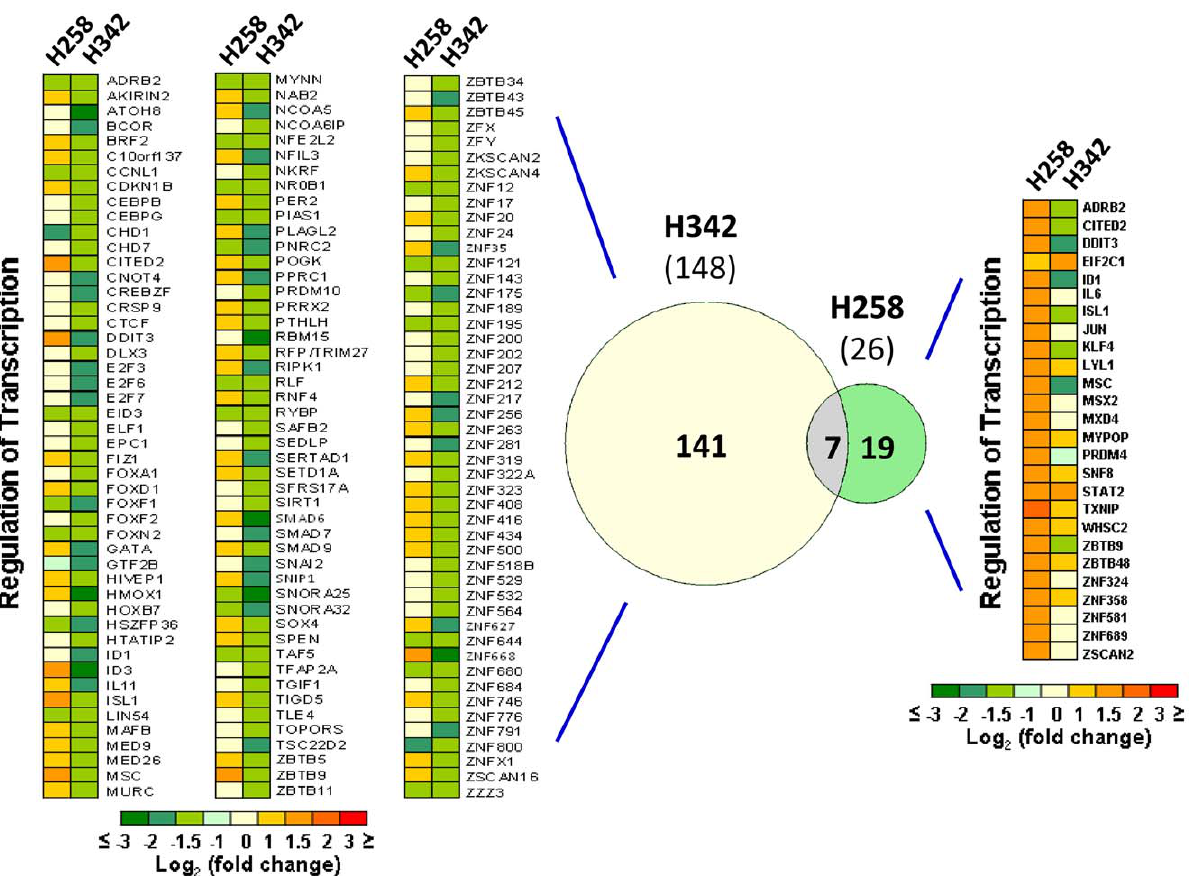
Figure 8. Comparison of gene expression signatures induced by H258 and H342. Heat map showing kinetics of changes in expression of transcription regulation genes identified in H342- and H258-induced global gene expression profiles based on DAVID Bioinformatics Database gene descriptions.148 H342-downregulated transcription regulation genes (left). Venn diagram (middle) illustrating 7 overlapped genes between H342- downregulated and H258-upregulated genes of transcription regulation. 26 H258-upregulated transcription regulation genes (right).